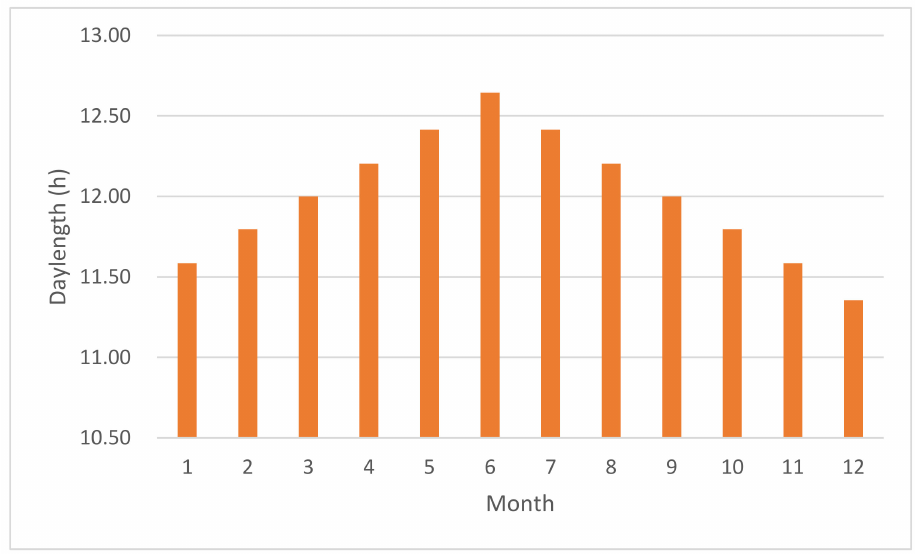
Figure 2. The monthly average day-length in the study